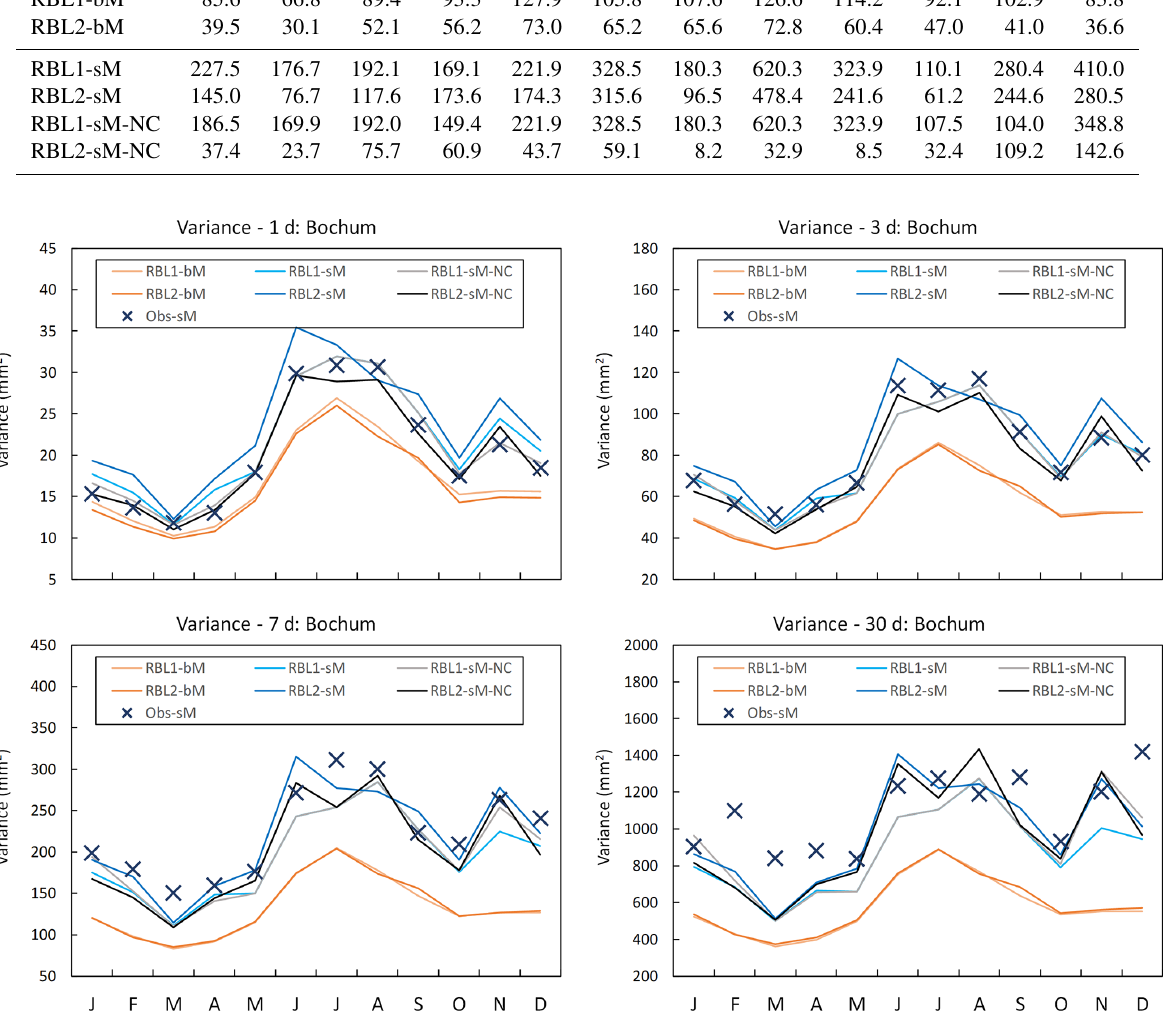
Figure 13. Daily variances by month at Bochum: the observed daily variances calculated with standard (Obs-sM, blue cross markers) methods, those fitted with the RBL1 (RBL1-bM, light orange line; RBL1-sM, light blue line; RBL1-sM-NC, grey line) models and those fitted with the RBL2 (RBL2-bM, orange lines; RBL2-sM, blue lines; RBL2-sM-NC, black line)